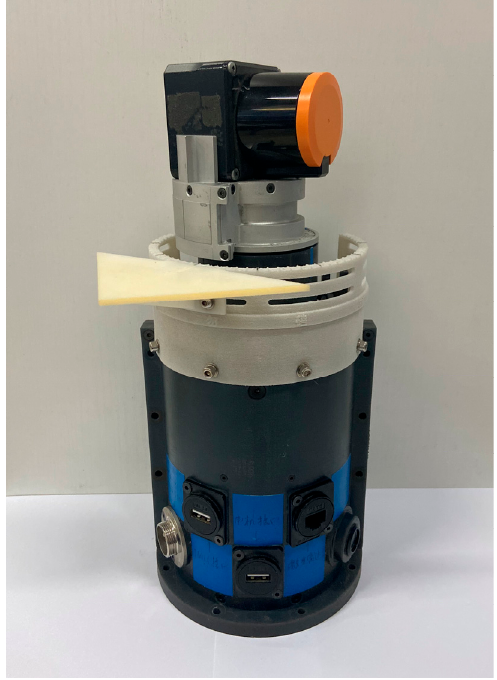
Figure 3. A photo of our prototype. The 2D lidar Hokuyo UST-10LX is installed on a rotating unit, and a triangular plate is used to calibrate the attitude error of the 3D point cloud.